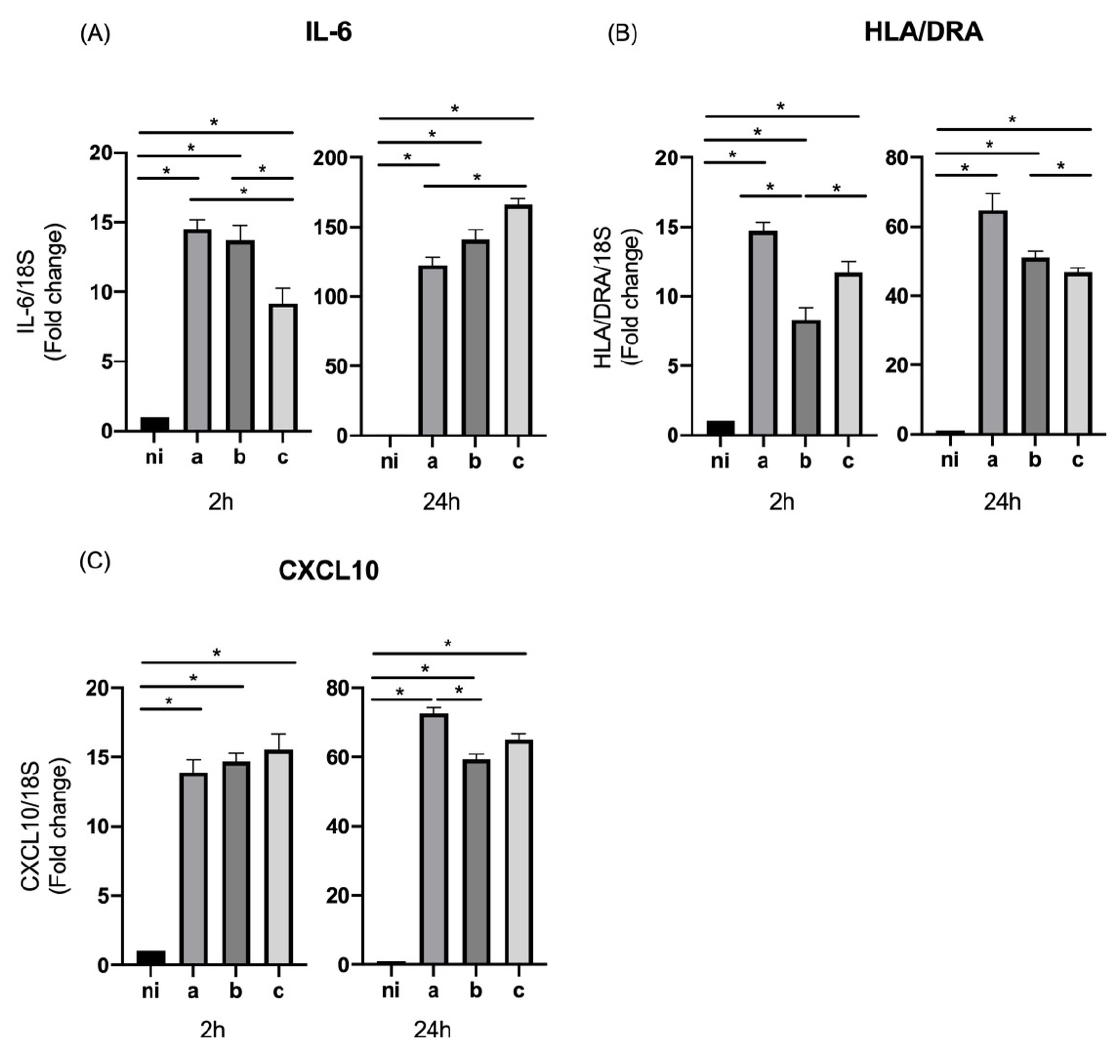
Figure 2. M1 markers’ expression by Aggregatibacter actinomycetemcomitans -induced THP-1 human macrophages (ATCC ® TIB-202TM). Expression in macrophages infected at an MOI = 102 with strains ATCC ® 43717TM (serotype a), ATCC ® 43718TM (serotype b), and ATCC ® 43719TM (serotype c), 2 and 24 h after infection. For relative expression, mRNA expression in non-infected (ni) macrophages was considered as 1, as a reference for fold-change in expression using 18S rRNA expression levels as a normalizing endogenous control. Data are represented as fold-change means and standard deviation of three independent experiments performed in duplicate. Asterisks were used to indicate a value of p considered statistically significant (* p < 0.05).